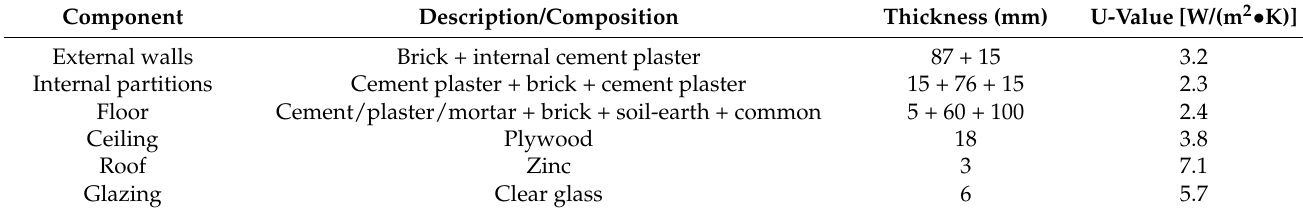
Table 5. Building materials and their corresponding properties assigned for the model.